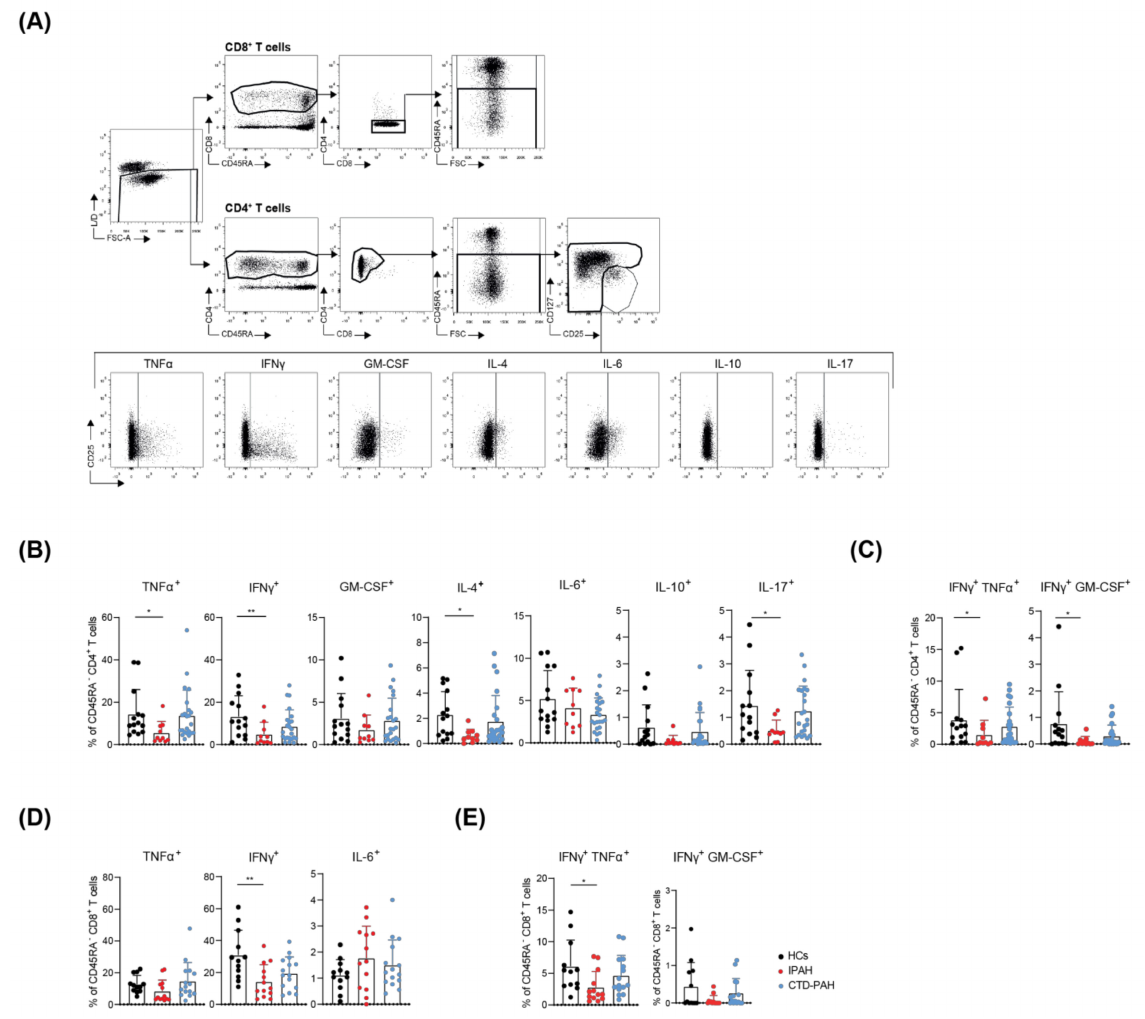
Figure 1. Circulating T cells of treatment-naive IPAH patients show reduced cytokine-producing ca- pacity. ( A ) Flow cytometric gating strategy of cytokine production by circulating non-Treg CD45RA − memory CD4 + T cells. ( B , C ) Quantification of the proportions of CD45RA − CD4 + memory T cells producing the indicated cytokines in HCs, IPAH and CTD-PAH patients ( B ), with a subsequent quantification of the proportions of double-producers ( C ). ( D , E ) Quantification of the proportions of the cytokine-producing CD45RA − CD8 + memory T cells in the indicated patients and HC groups ( D ), with a subsequent quantification of the proportions of double producers ( E ). ( A – E ) Samples with <500 events in parent gate were excluded from the analysis. Results are presented as mean + standard deviation; symbols represent value of individual patients or HCs. Mann–Whitney U test was used for statistical analysis, * p < 0.05, ** p <